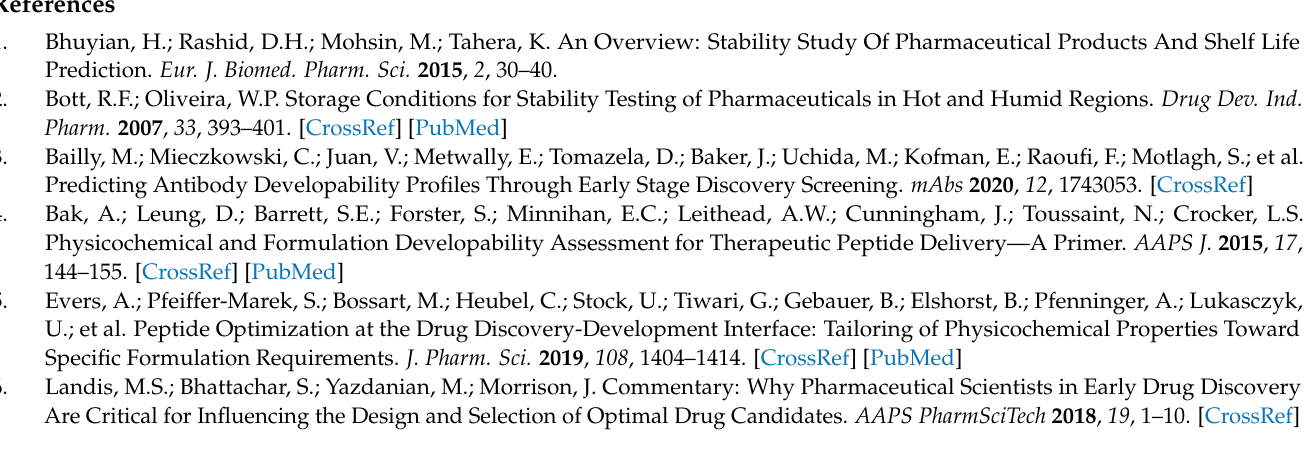
concentration, Table S2: Gradient table for LC method to detect degradation products, Table S3: Supplier details for primary packaging materials used during stability studies of the peptide, Table S4: List of reagents for peptide purity determination, Table S5: Analytical conditions for peptide purity determination, Table S6: Gradient details for peptide purity determination, Table S7: List of reagents for peptide HMWP determination, Table S8: Analytical conditions for peptide HMWP determination, Table S9: Approximate retention times for peptide HMWP determination. Experimental data for stability prediction are available as an Excel